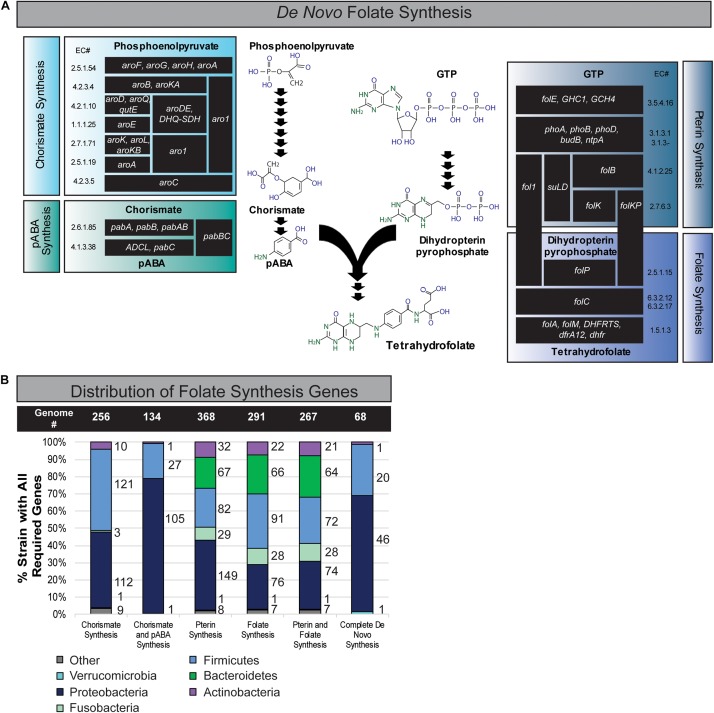
Distribution of folate synthesis genes in the gastrointestinal human microbiome. (A) Schematic of de novo folate synthesis divided into four modules: (1) chorismate synthesis, (2) pABA synthesis, (3) pterin synthesis, and (4) folate synthesis. Each protein is listed by name and enzyme commission (E.C.) number. (B) Distribution of genomic folate synthesis capabilities within the Human Microbiome Project’s Gastrointestinal Reference Genomes stratified by phylum.